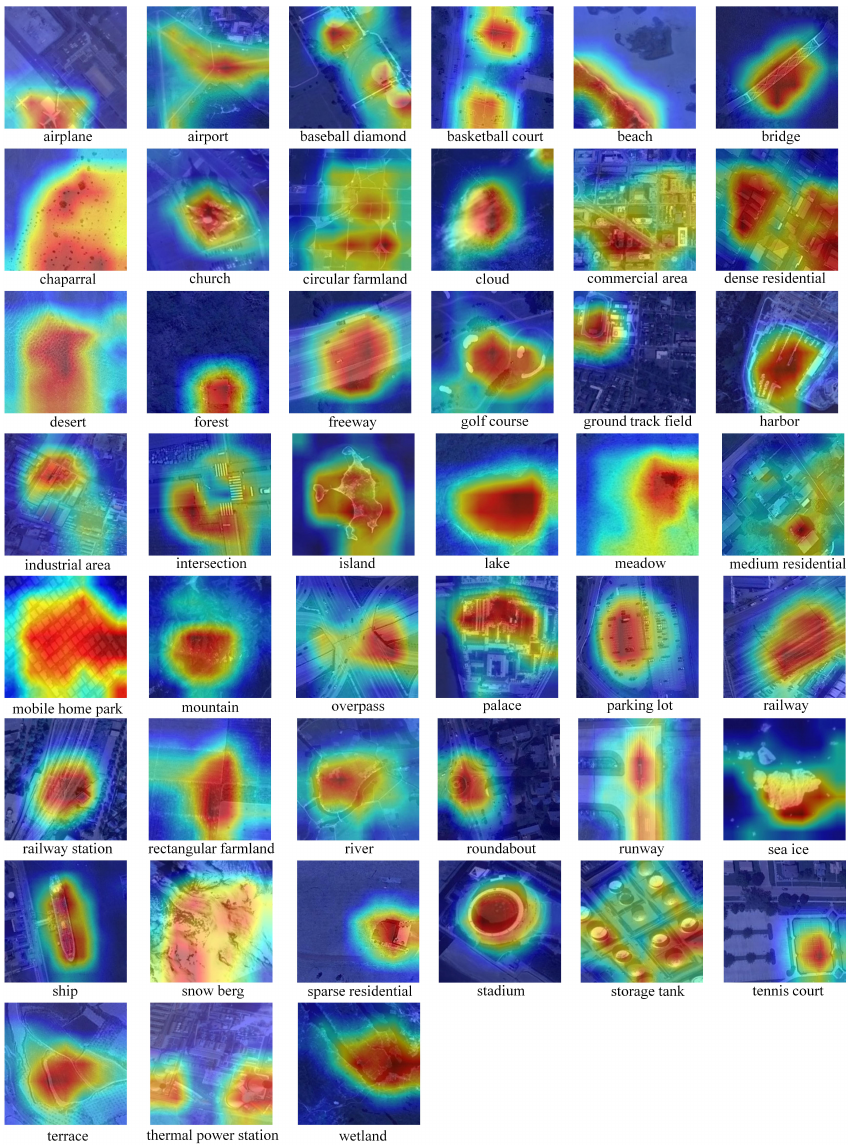
Figure 11. Heat maps generated by Grad-CAM. All samples are from the NWPU-RESISC45